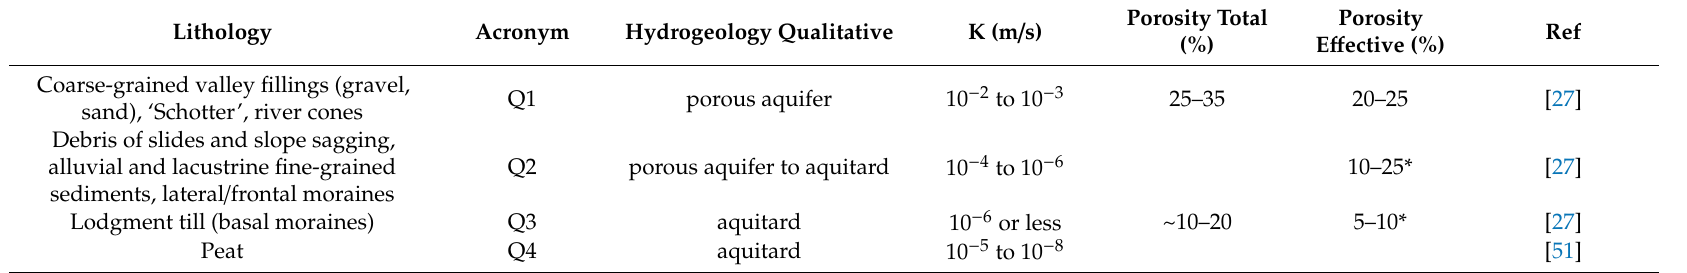
Table 2. Quaternary lithologies with hydrogeological properties based on values from the